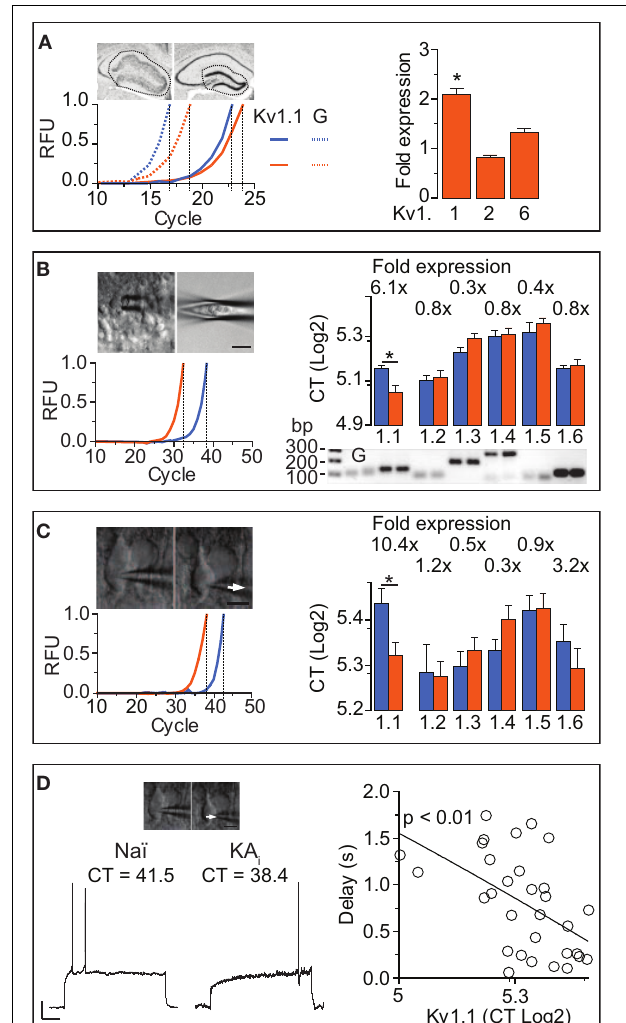
FIGURE 4 | RT-qPCR reveals that Kv1.1 channel subunits mediate the I D increased in DG cells during hippocampal epilepsy. (A) In a first RT-qPCR approach, whole DGs were dissected from acute brain slices and expression levels of Kv1.1, Kv1.2, and Kv1.6 were measured relative to GAPDH [ left upper panels: scheme of dissection; left lower panel, solid lines: red , naïve; blue , KA; dashed lines: GAPDH; RFU , relative fluorescence units; traces normalized to cycle threshold (CT)]. In the right panel , the relative expression levels of Kv subunits were statistically compared between KA and control tissue (not shown). Kv1.1 was expressed ∼ 2 fold in the epileptic DG, while Kv1.2, and Kv1.6 were not significantly different (in KA vs. control tissue). (B) DG cell somata were collected into the pipette in a “pearl” fashion (see Methods, left upper panels ) and mRNA reverse transcribed to cDNA which was subjected to qPCR. Real time amplification of Kv1.1 ( left lower panel ; blue , naïve; orange , KA). The amplified PCR products of Kv1.1, Kv1.2, Kv1.3, Kv1.4, Kv1.5, and Kv1.6 subunits, and GAPDH (G) had the expected fragment sizes as revealed by quantitative gel electrophoresis ( right lower panel ; bp , base pairs). Relative to naïve DG cells, expression levels of Kv1.1 subunits were increased in KA samples, while Kv1.2, Kv1.3, Kv1.4, Kv1.5, and Kv1.6 abundance was not significantly changed ( right upper panel ). (C,D) In a second approach, true